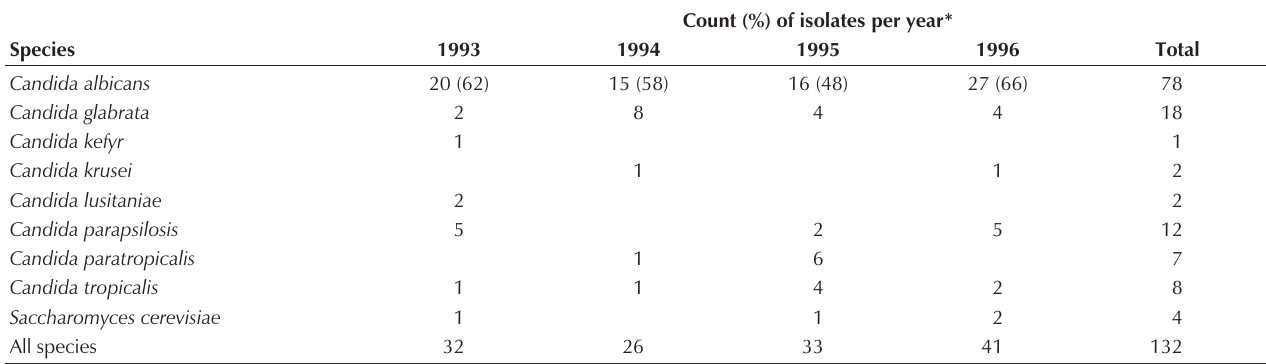
Count (%) of isolates per year*